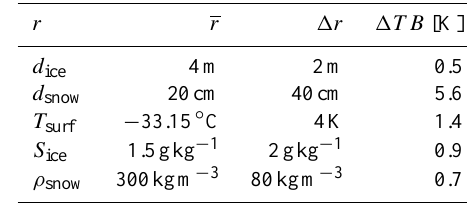
Table 1. The ice parameters r influencing the brightness temper- ature, their average values r (as used in Fig. 3 for all parameters except for the one that is varied), the ranges in which the param- eters are varied 1r , and the impact on the brightness temperature 1T B